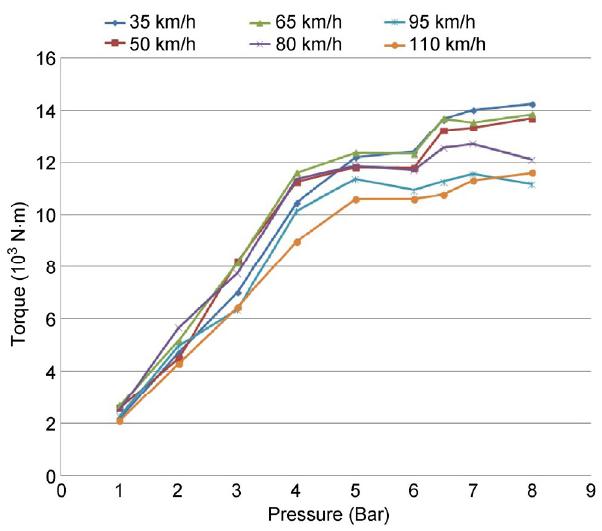
Fig. 3 Braking torque vs pressure (1–8 Bar) at different speeds of the inertia wheel (35–110 km/h).